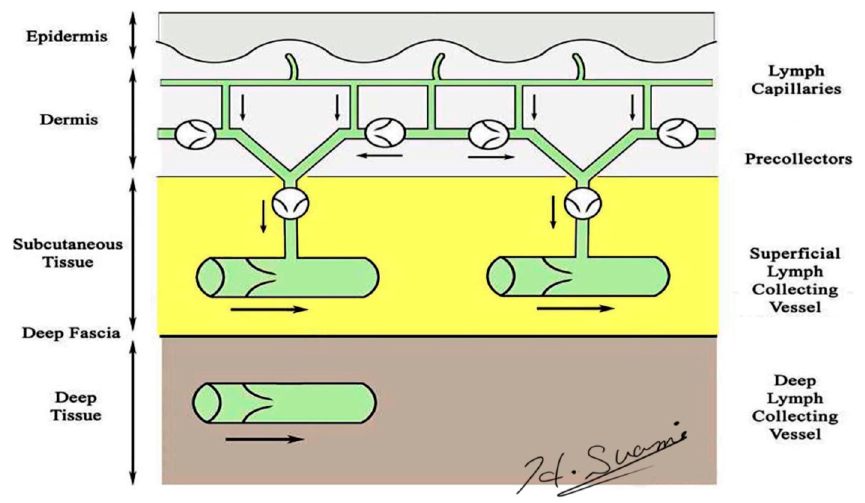
Figure 1. Schematic diagram of the lymphatic system. (Reproduced with the permission of Hiroo Suami).